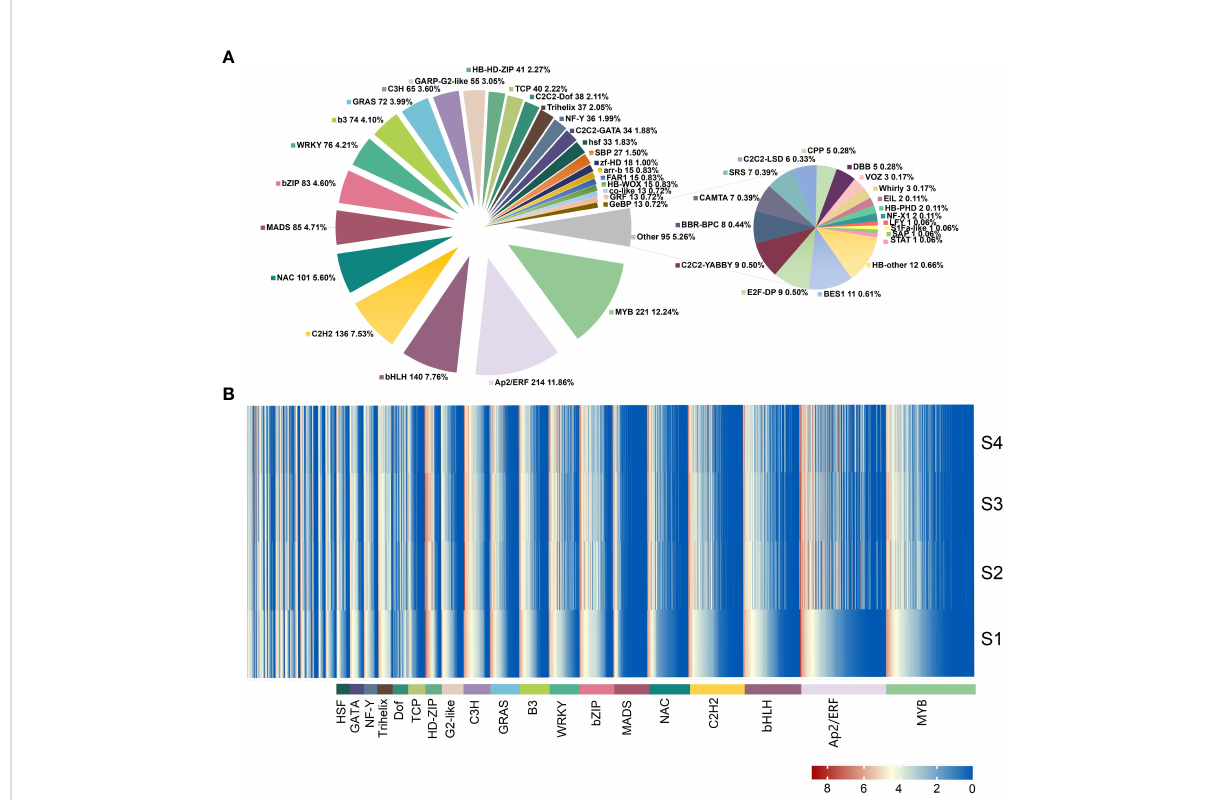
FIGURE 4 Transcription factor family analysis. (A) Summary of transcription factor families, the pie chart showed the number and proportion of each transcription factor family; (B) Expression pattern analysis of transcription factor family genes using heatmap. The data were calculated using log2